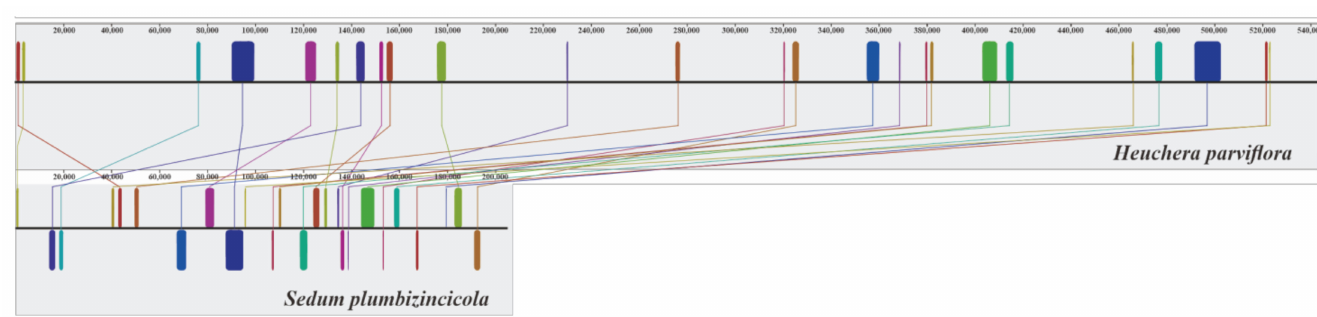
Figure 2. Mitogenome synteny between S. plumbizincicola and H. parviflora . The sequence of H. parvi- flora was selected as reference. The minimum locally collinear block size was 1006. The homologous regions shown with same colors.